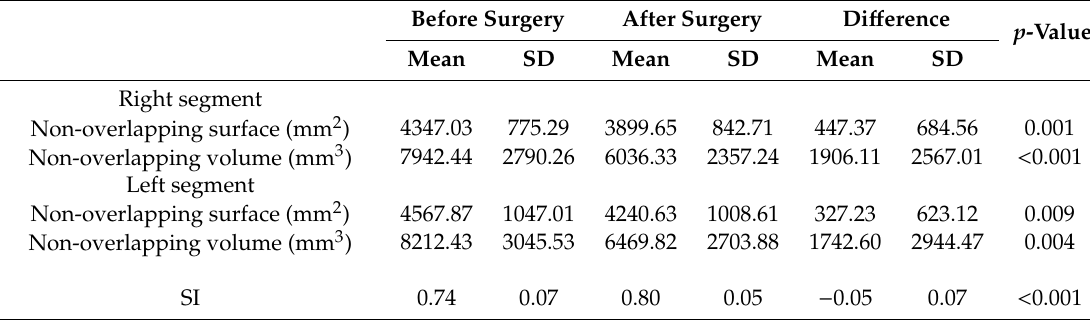
Table3. Di ff erencesinthenon-overlappingsurface, volume, andsimilarityindex(SI)usingthemirroring technique based on the MSP before and 1 year after